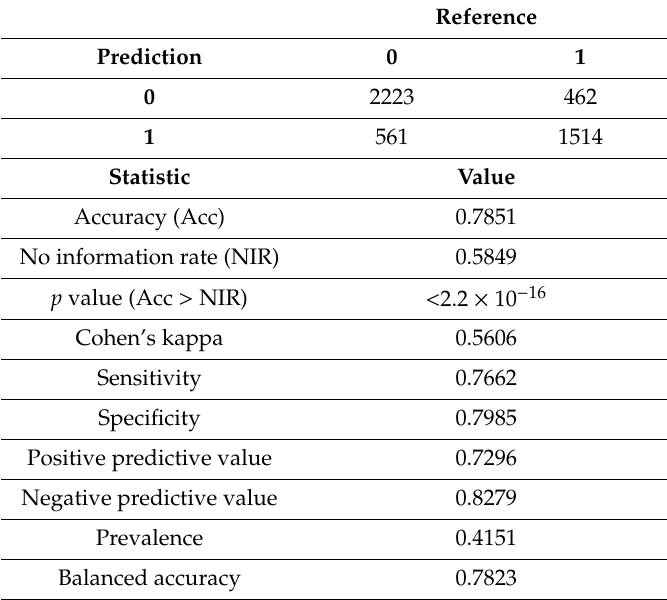
Table 3. Confusion matrix and other statistics resulting from the analysis of the final random forest model with the test dataset at a probability cuto ff of